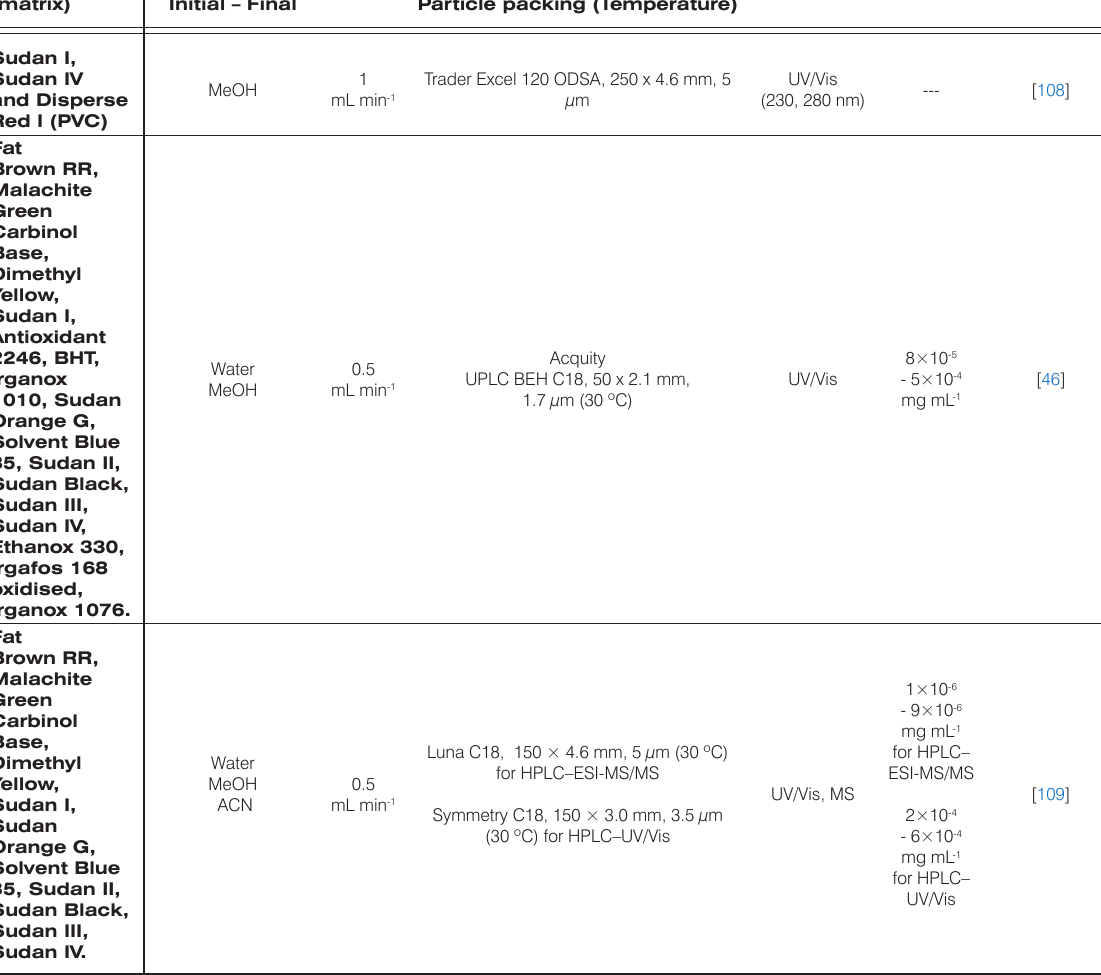
Table 5. Summary of liquid chromatography based methods for the determination of colorants in plastics. Analytes